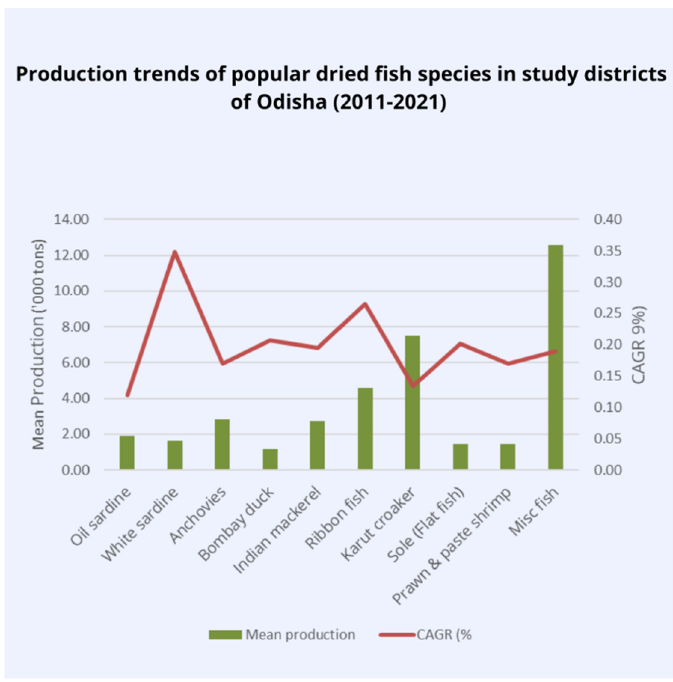
Figure 6. Decadal mean production and cumulative annual growth rate of select dried fish species over the period from 2011–12 to 2021–22 (Source: GoO [48]).